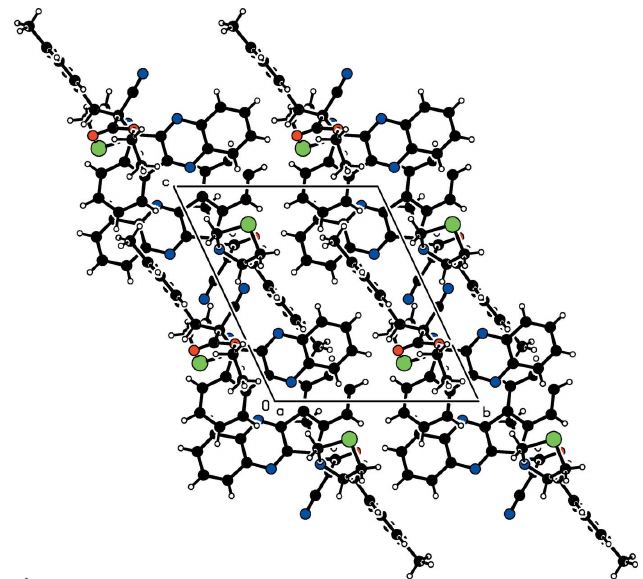
Figure 2 Packing diagram of the title compound viewed down the a axis. Hydrogen bonds are shown as dashed lines. The minor component of the disordered –CH 3 group (C20 atom) is omitted for clarity.